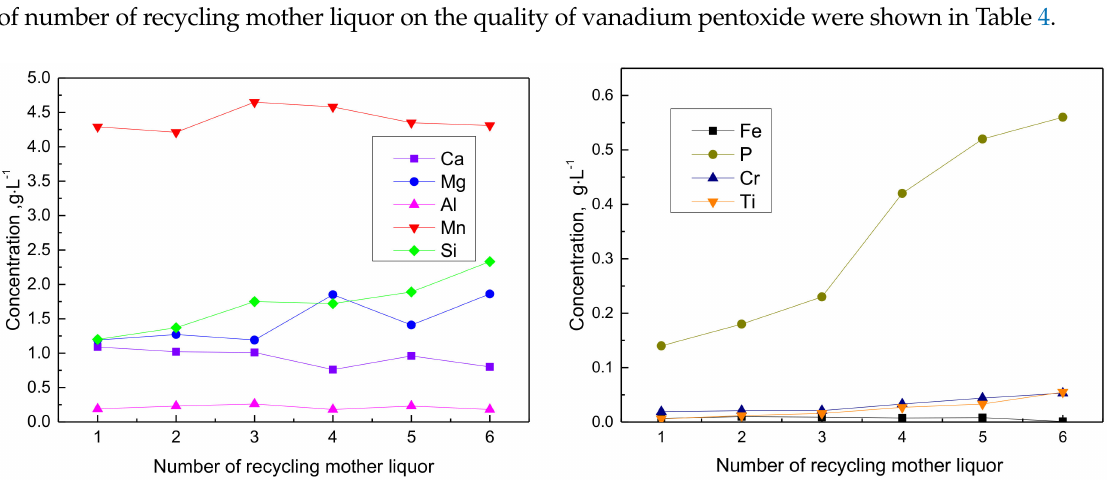
Figure 11. Relationships between concentrations of impurities and the number of recycling mother liquor ( a ) variation of the concentration of main impurities of Ca, Mg, Al, Mn and Si as the recycle increases; ( b ) variation of the concentration of the minor impurities of Fe, P, Cr and Ti as the recycle increases. Table 4. Effect of the number of recycling mother liquor on the quality of final product (wt. %). Number of